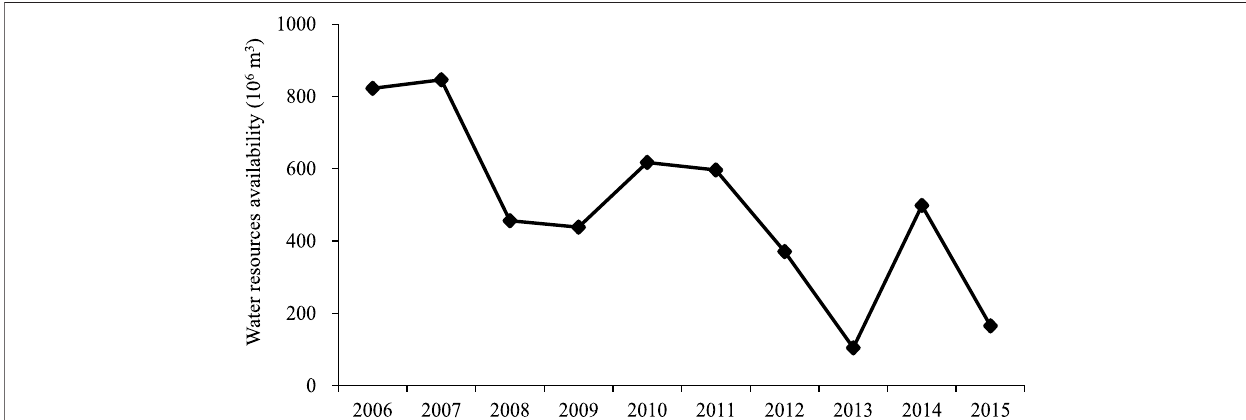
FIGURE 12 | The average water availability in the Huangshui River in the baseline period.